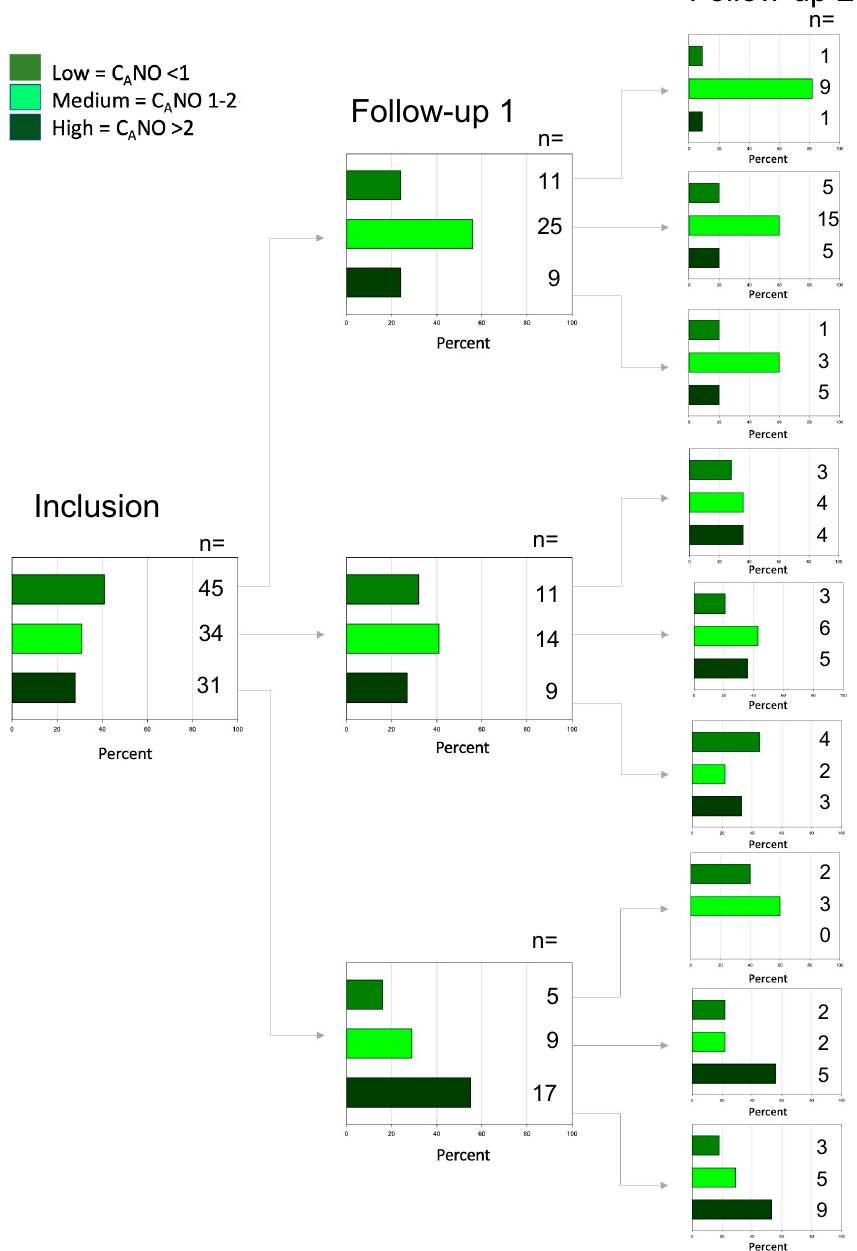
Figure 2. The estimation of C A NO at inclusion and each follow-up during the two-year period. The subjects are grouped in low <1 ppb, medium 1–2 ppb, and high >2 ppb.